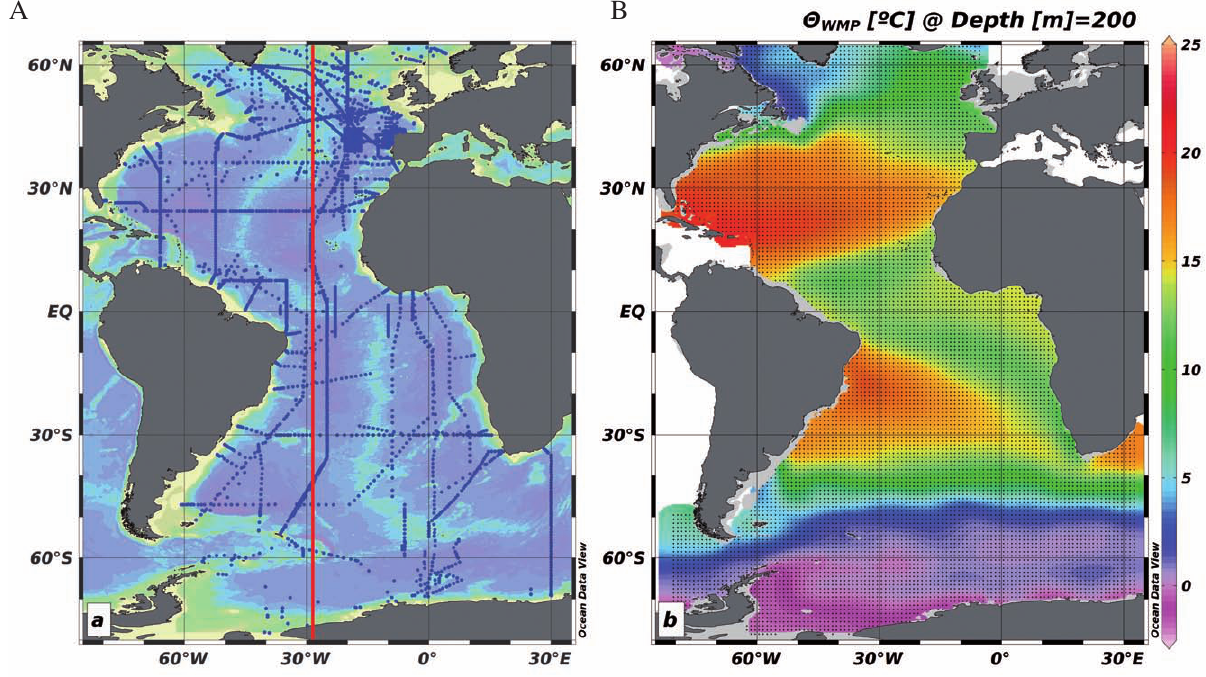
Fig . 1. – A, CARINA stations with available variables needed to estimate C